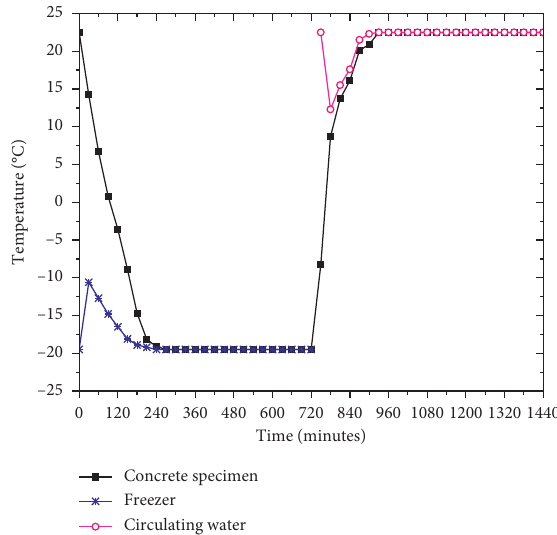
Figure 1: Temperature-time curve in a freeze-thaw